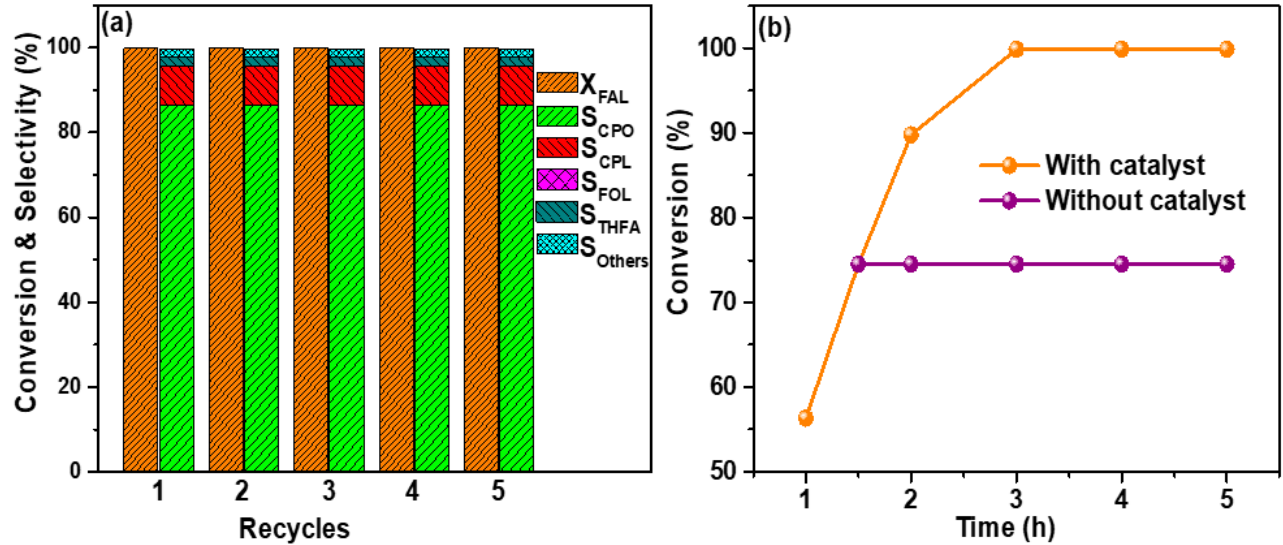
Figure 9. ( a ) Recycled catalyst tests for stability verification of Ni 5 Cu 15 /m-SiO 2 catalyst and ( b ) leach- ing test for FAL hydrogenation of 5.2 mmol FAL, and 15 mL water, 3 MPa H 2 and X-conversion of FAL, S-selectivity of desired products.